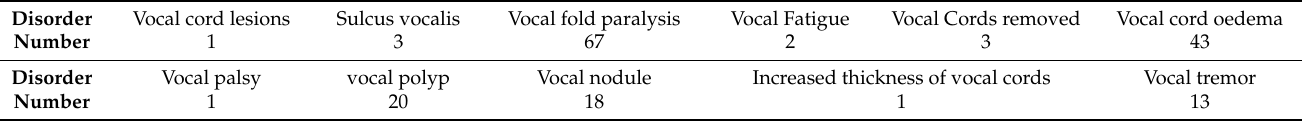
Table 4. All voice disorders in